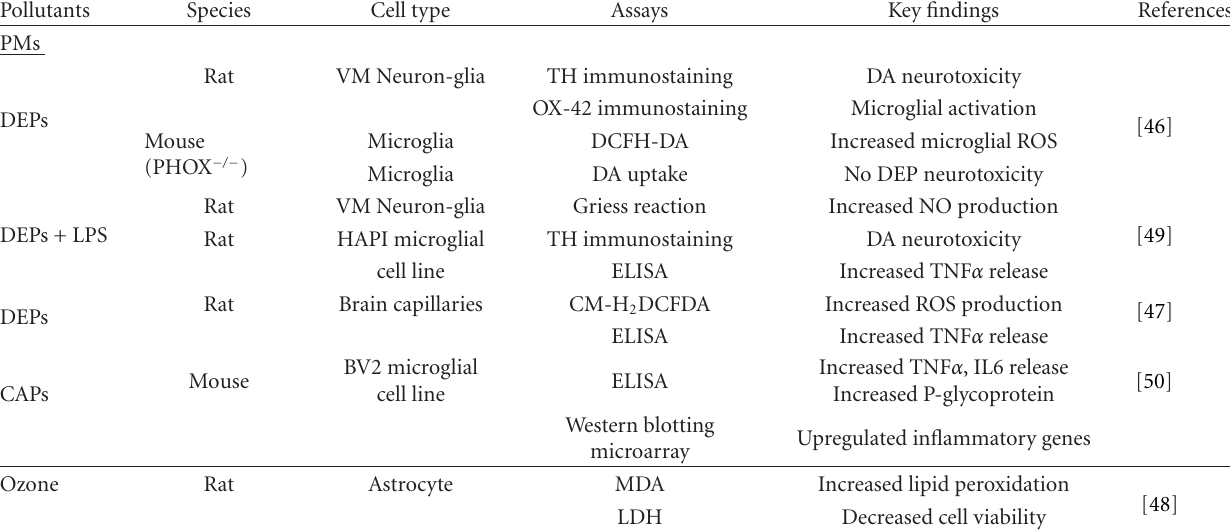
Table 1: The e ff ects of air pollutants on neuronal and glial cells in vitro